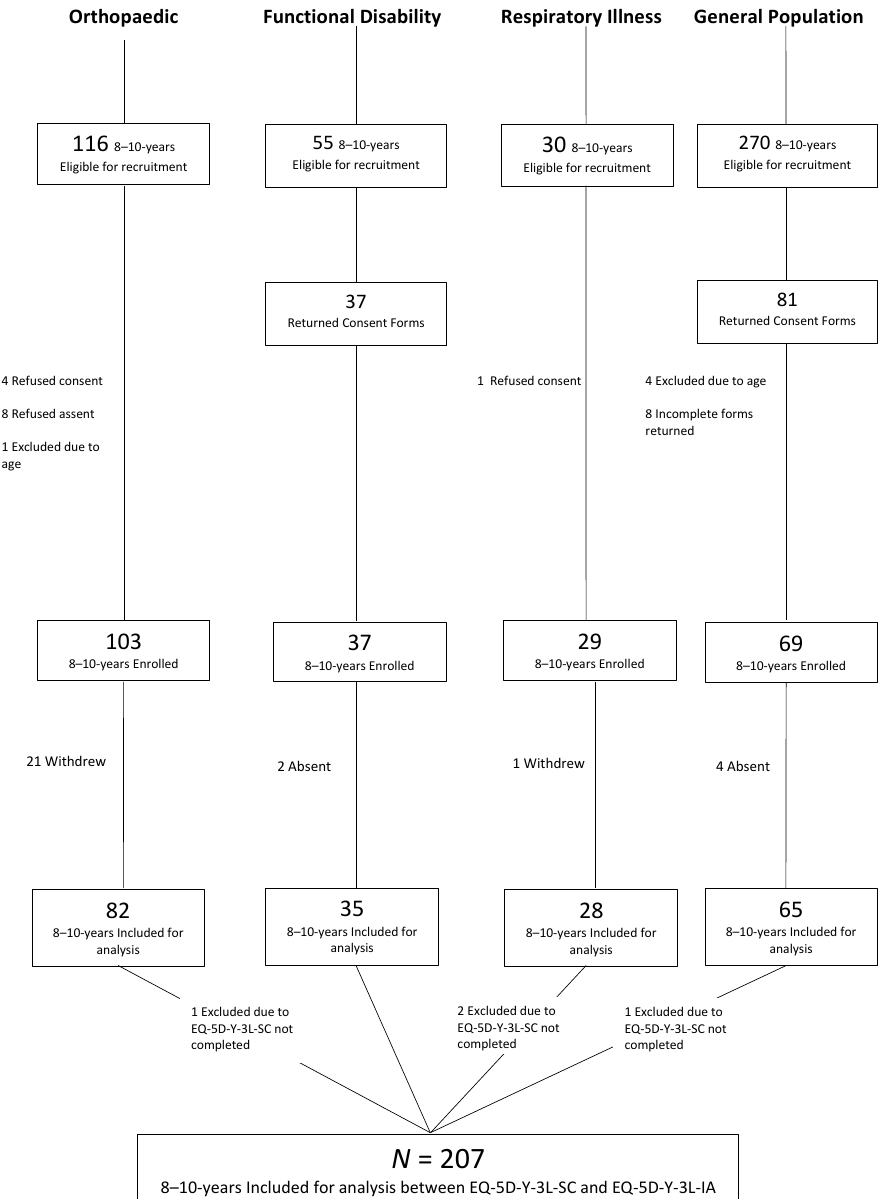
Figure 1. Recruitment of sample.